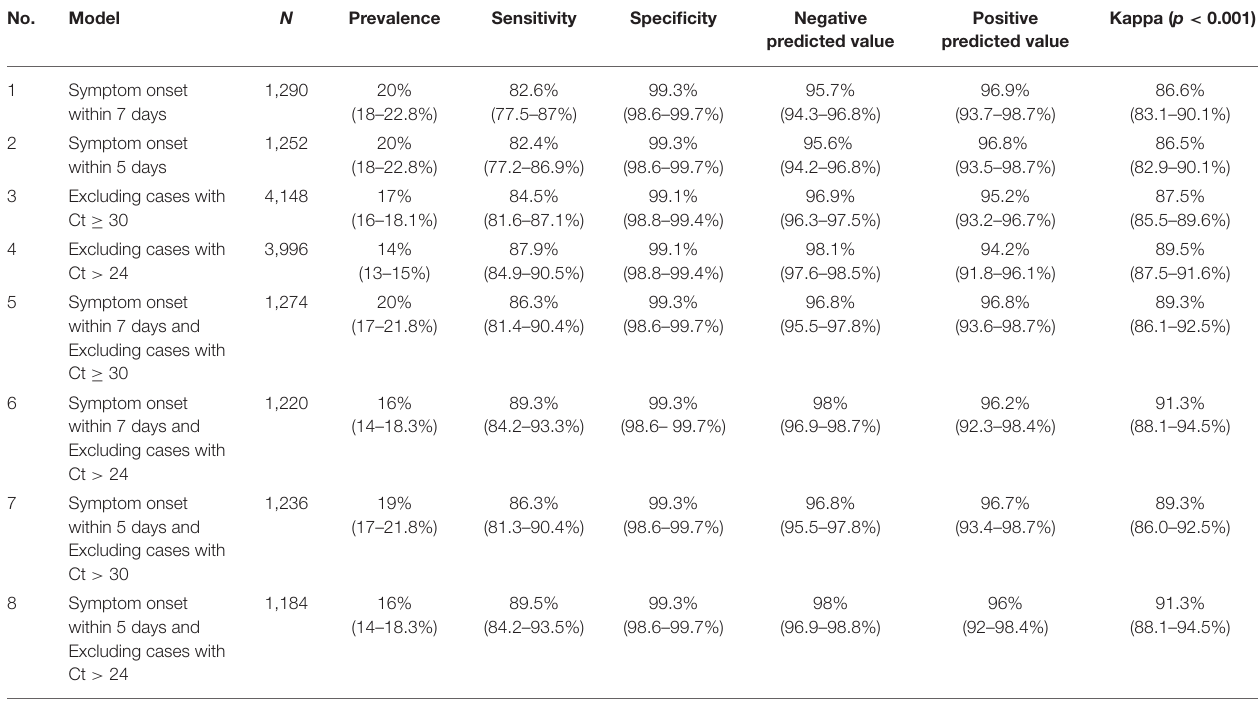
TABLE 4 | The effect of symptoms onset time and Ct values on the diagnostic performance. No. Model N Prevalence Sensitivity Specificity Negative